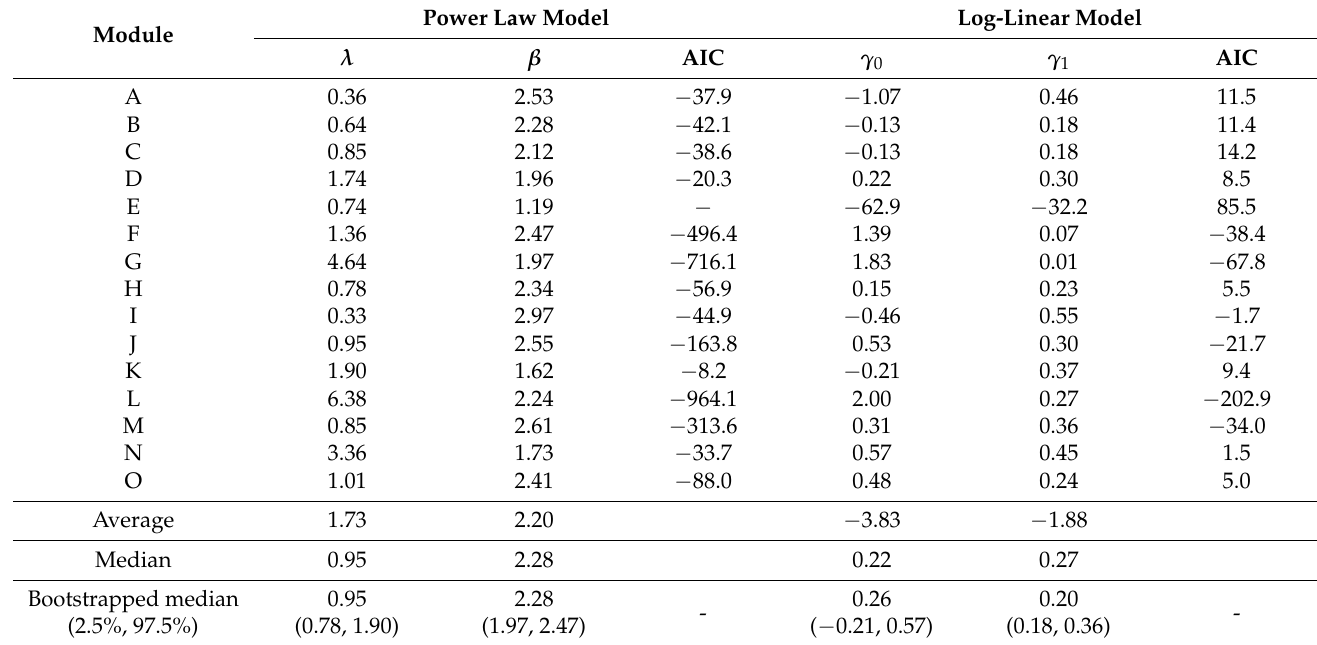
Table 4. Estimated parameters for each